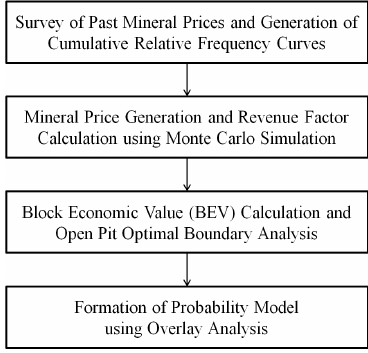
Figure 1. Study process of uncertainty representation for pit optimization results using the proposed method.